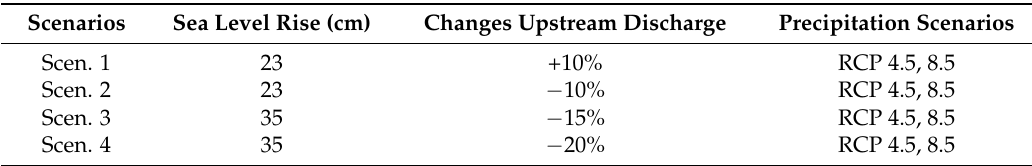
Table 4. Four scenarios of changing of discharges, sea level rise and